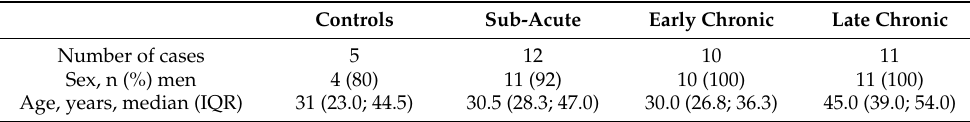
Table 1. Gender and age distribution of SCI cases included for CSF analysis. Controls Sub-Acute Early Chronic Late Chronic Number of